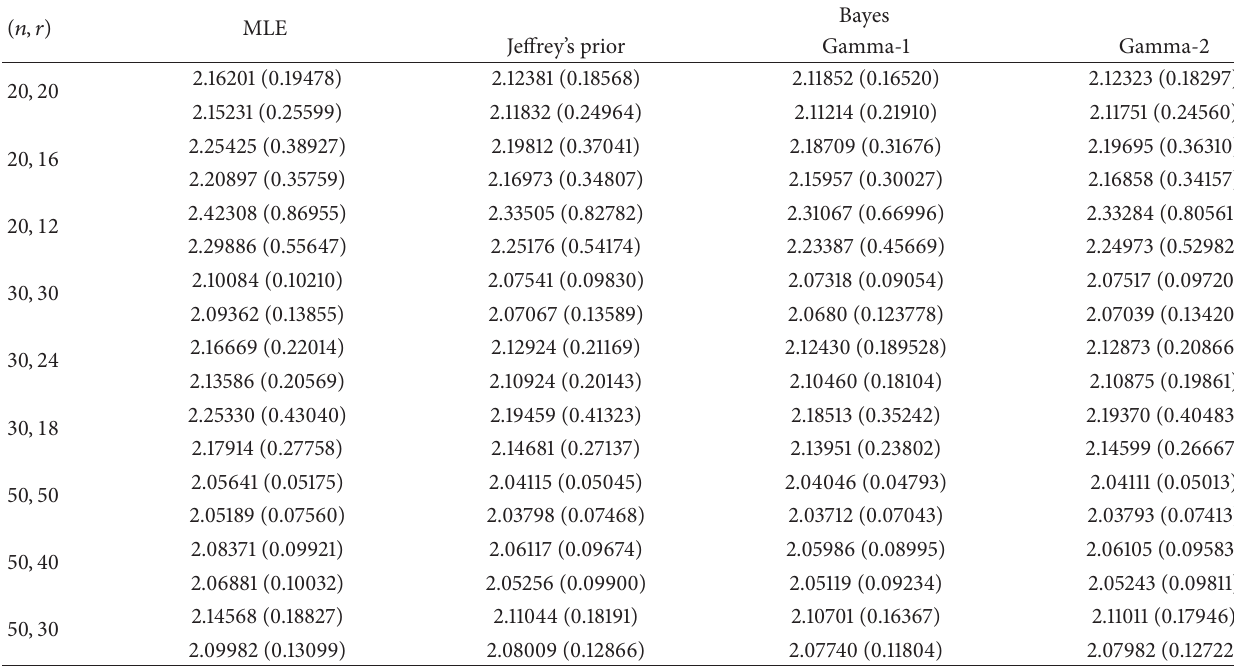
Table 1: Average estimates and MSEs (in the brackets) of the estimators of 𝛼 (in the first row of each cell) and 𝛽 (in the second row of each cell) under different Type-II censoring schemes for fixed values of 𝛼 = 2 and 𝛽 = 2